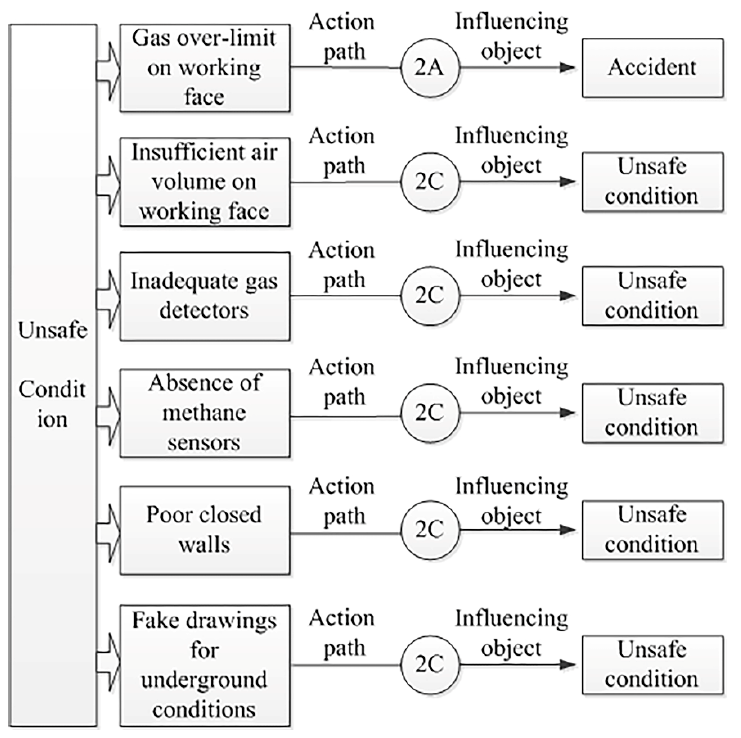
Figure 6. Analysis of unsafe conditions.